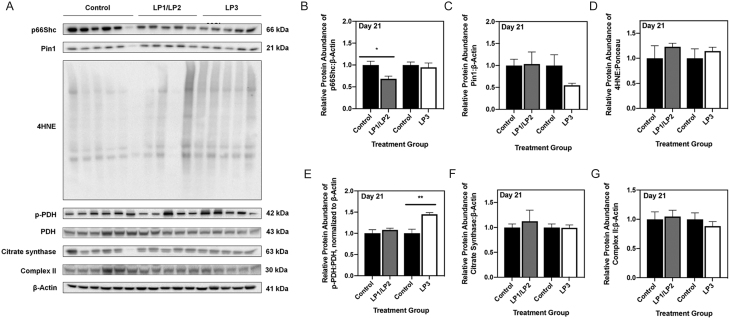
Maternal protein restriction does not independently contribute to increased p66Shc or oxidative stress at 3 weeks of age. (A) Representative Western immunoblots of specific targeted protein bands for control, LP1/LP2, and LP3 offspring as detected by primary antibodies. (B) p66Shc, (C) PIN1, (D) 4HNE, (E) p-PDH, (F) citrate synthase, and (G) complex II protein abundances were compared in each group of MPR offspring against control offspring. 4HNE abundance was expressed as means normalized to total protein abundance ± s.e.m. (n = 7–8/group), while abundances of all other targets were normalized to β-Actin ± s.e.m. (n = 7–8/group). All protein abundances were analyzed using a two-tailed unpaired Student’s t-test. *Significant difference (P < 0.05), **significant difference (P < 0.01).